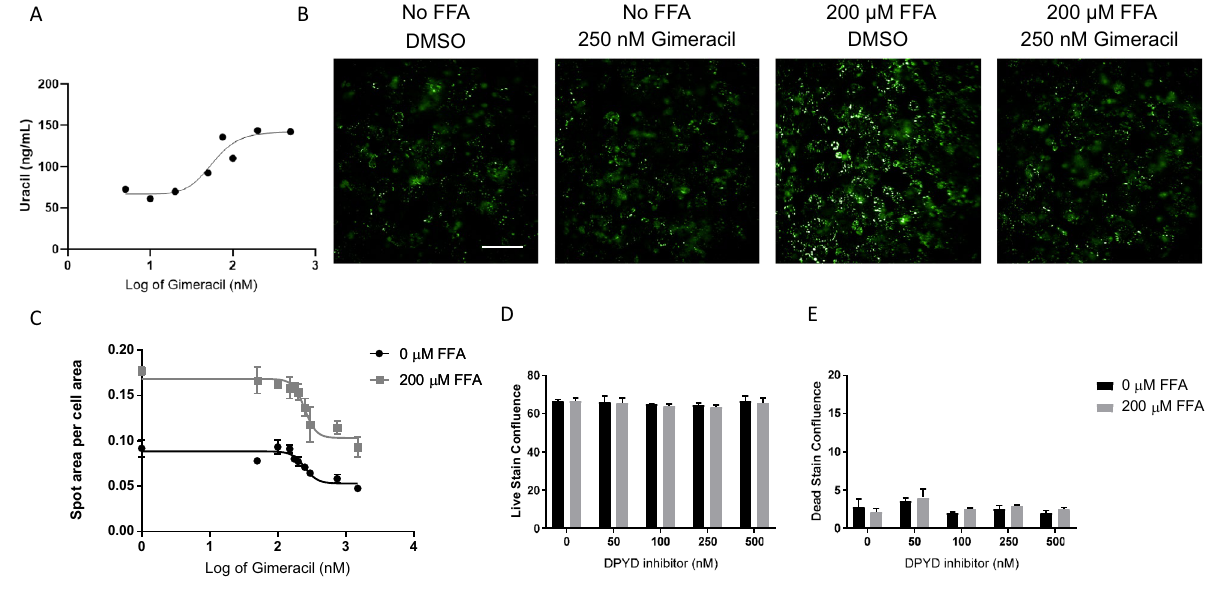
Figure 2. DPYD inhibition reduces lipid burden in an in vitro model of steatosis. ( A ) The inhibition of DPYD led to increased uracil levels in media collected from treated PHHs with an IC50 of 56 nM. ( B ) While an increase in LipidTox signal intensity is observed in the presence of 200 µM FFAs, this effect is diminished in the presence of 250 nM Gimeracil, a DPYD inhibitor. Scale bar represents 100 µM. ( C ) Quantification of lipid droplet accumulation in the hepatocytes with an Operetta Harmony image analysis pipeline (spot area per cell area) highlights a more than twofold increase in lipid droplet area with exposure to FFAs (square) relative to vehicle treatment (circle). Gimeracil exposure significantly reduces lipid droplet accumulation in both the FFA and vehicle control conditions in a dose responsive fashion. The degree to which Gimeracil inhibits lipid accumulation in the presence of fatty acids is represented by an IC50 value of 247.8 nM with an R 2 of 0.8481. ( D ) Cell viability is not significantly impacted by either FFA exposure (200 µM) or DPYD inhibitor up to a concentration of 500 nM as measured by a calcein AM stain confluence quantified by the Incucyte Zoom analysis software. ( E ) Neither 200 µM FFA exposure or DPYD inhibition in the range of 50–500 nM is cytotoxic as measured by Ethidium homodimer-1 staining and quantification of confluence with the Incucyte Zoom analysis